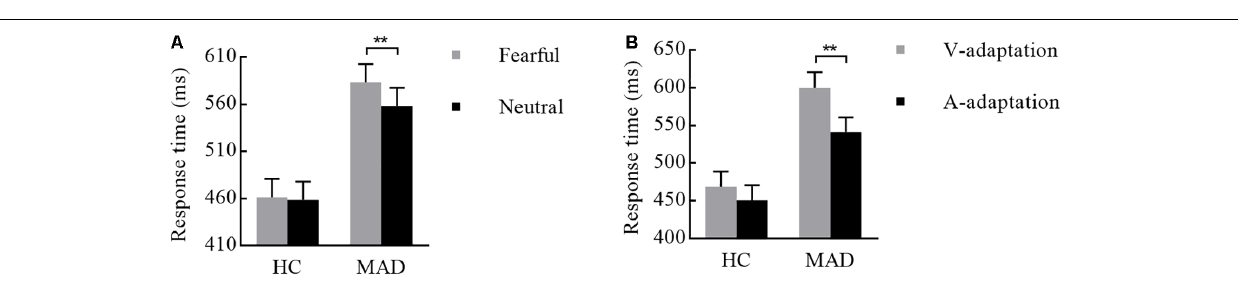
FIGURE 6 | Combination of the results of RT for Experiment 3. (A) MADs showed a longer RT for neutral than for fearful cues, but HCs did not. (B) MADs showed a longer RT in V-adaptation than A-adaptation, but HCs did not. ** p <